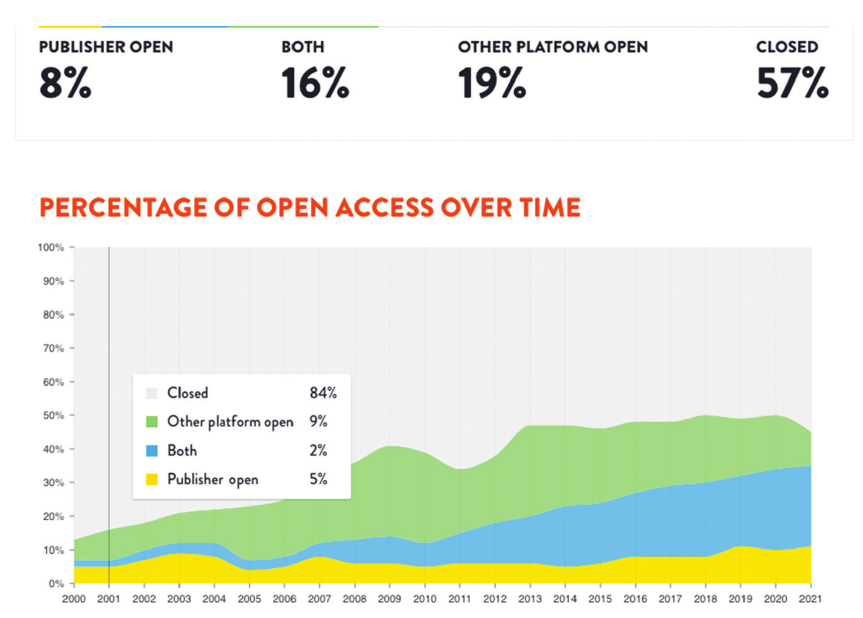
Fig. 7: Types of open access research output for Curtin University, 2000–2021. Data sources: Crossref, Unpaywall, Microsoft Academic. Analysis and Image: Curtin Open Knowledge